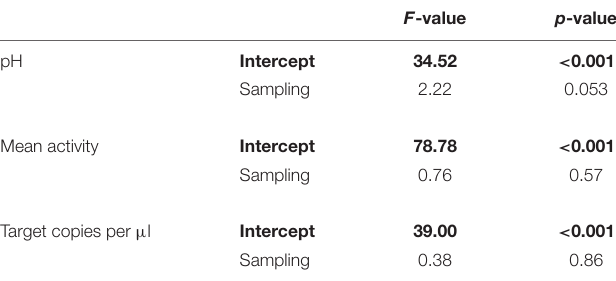
TABLE 2 | The results of one-way repeated measurements ANOVA with rank transformation examining a potential effect of sampling on pH, mean activity, and target eDNA copy